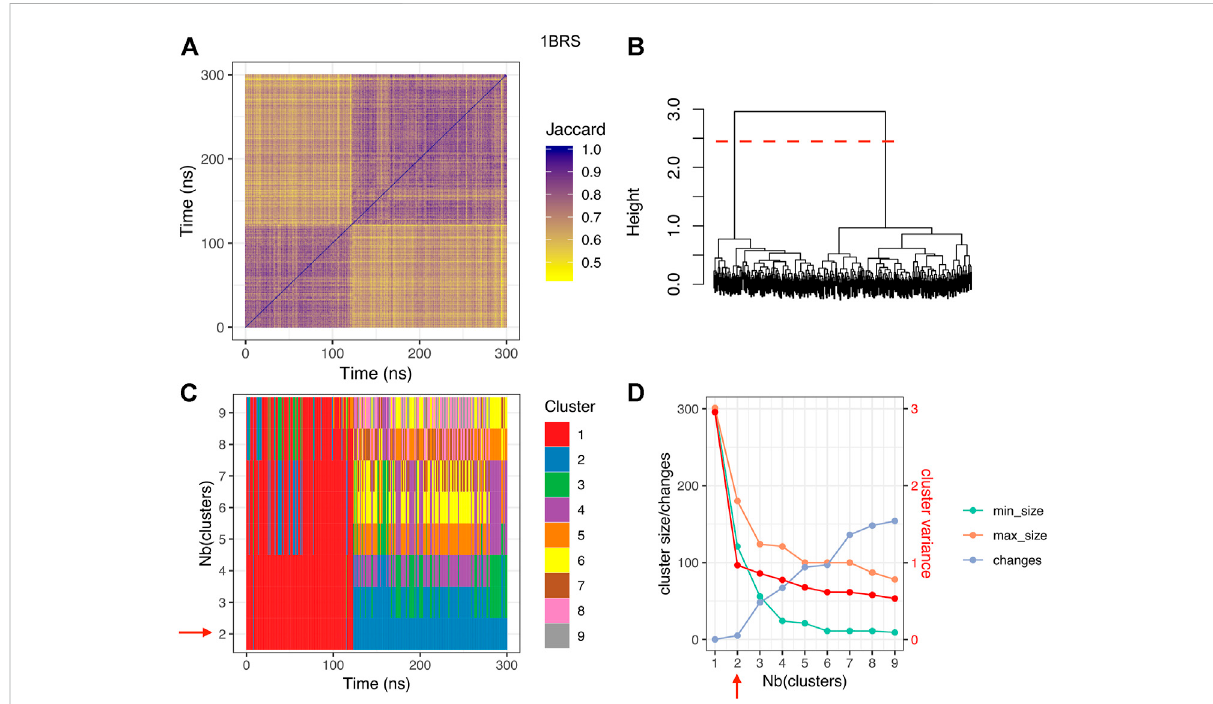
Clustering results for the barnase/barstar complex 1BRS. (A) Jaccard similarity matrix; for each pair of snapshots, a yellow pixel indicates low interfacesimilarity,andapurplepixelindicateshighinterfacesimilarity. (B) clusteringdendrogram. (C) clustermembershipalongsimulationtime,for differentnumbersofclusters. (D) clustersize,numberofchanges,andintra-clustervariance(red),fordifferentnumbersofclusters;min_size:sizeof the smallest cluster, max_size: size of the largest cluster, changes: number of cluster changes during the simulation. The red dashed line in panel (B) and the red arrows in panels (C,D) indicate the optimal number of